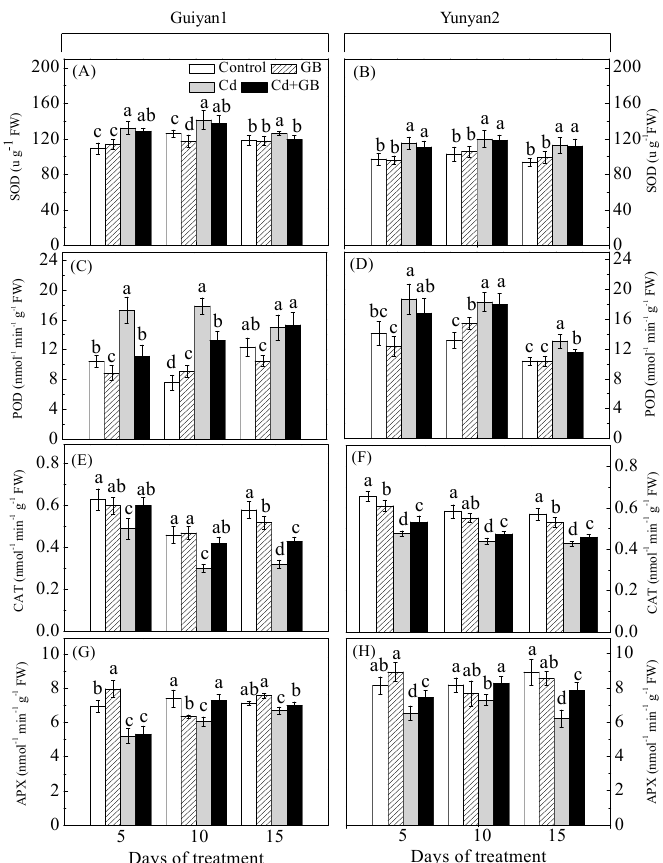
Figure 3. The effects of Cd and exogenous GB application on the superoxide dismutase (SOD) ( A , B ), peroxidase (POD) ( C , D ), catalase (CAT) ( E , F ), and ascorbate peroxidase (APX) ( G , H ) activity in the roots of two tobacco cultivars exposed to 5 μ M Cd for 5, 10, and 15 days: The error bars represent the SD values ( n = 3). The different letters indicate the significant differences ( p < 0.05) among the 4 treatments within each sampling date. Control, GB, Cd, and Cd + GB correspond to BNS + foliar spray of deionized water, BNS + foliar spray of 500 μ M GB, BNS + foliar spray of deionized water + 5 μ M CdCl 2 , and BNS + foliar spray of 500 μ M GB + 5 μ M CdCl 2 , respectively.